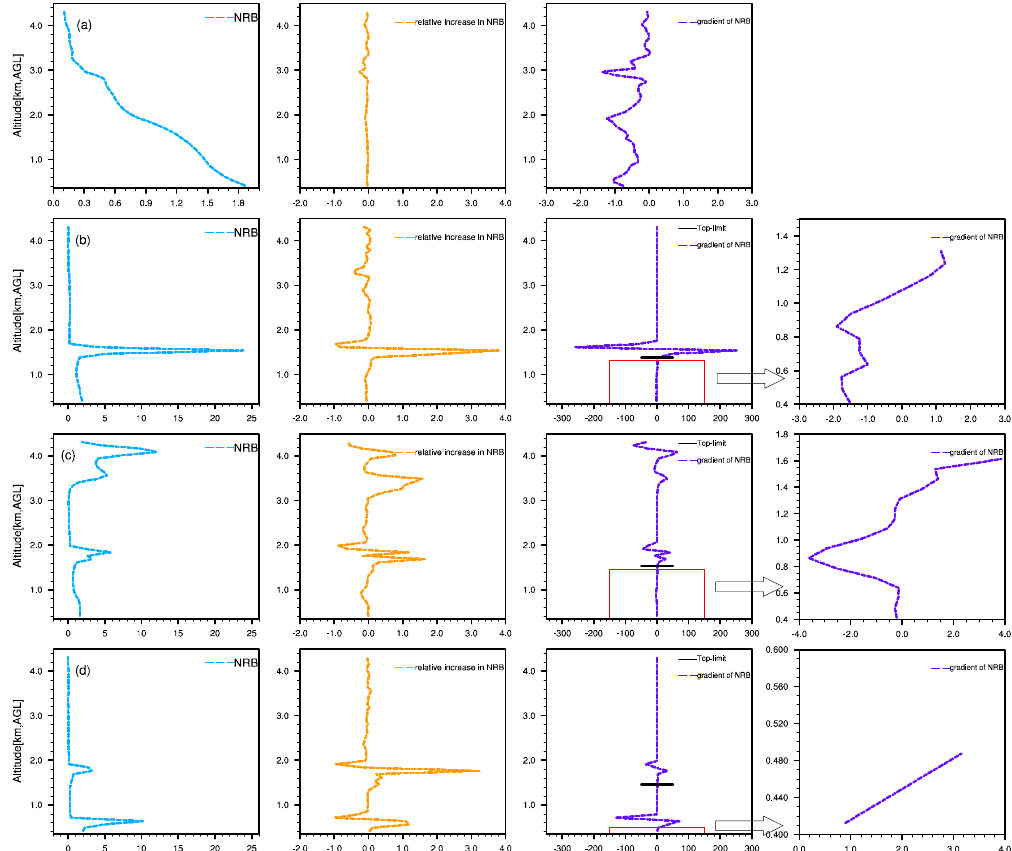
Figure 4. Vertical distributions of normalized relative lidar backscatter signal (NRB) (the first column), relative increase in NRB (the second column), gradient of NRB with the determined top limiter (the third column), and the gradient of NRB only below the lowest cloud layer (the last column) on typical situations: ( a ) Cloud-free, observed at 14:15 local standard time (LST), 09 June 2007; ( b ) one cloud layer is observed at 10:15 LST, 09 June 2007; ( c , d ) more than one cloud layers are observed, the lowest-altitude cloud in ( c ) (at 13:45 LST, 28 October 2007) is decoupled from the ABL while in ( d ) (at 10:15 LST, 28 October 2007) is within the ABL.